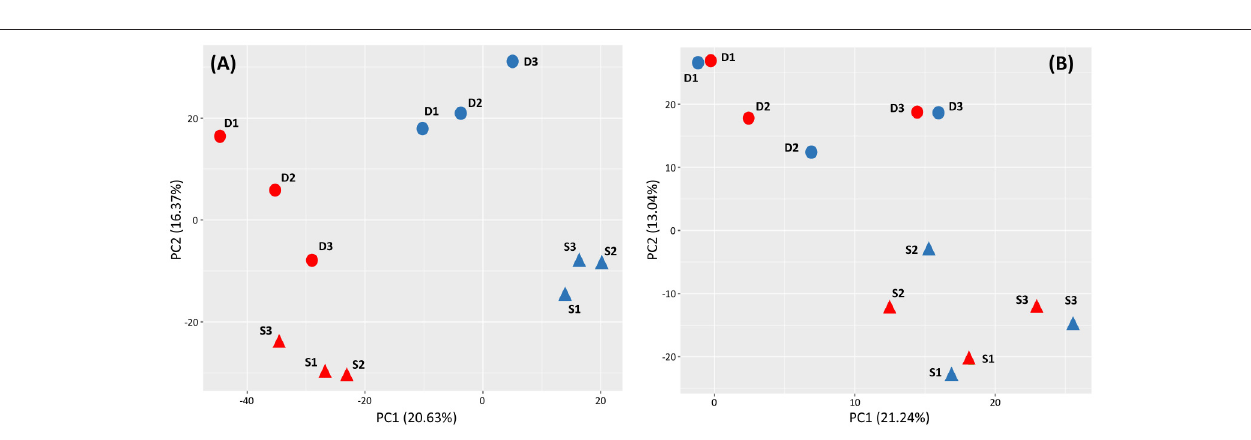
FIGURE 2 | Principal component analyses (PCA) performed with all 72,169 differentially expressed contigs (5% false discovery rate) found in shallow (triangles) and deep (circles) Posidonia oceanica plants at the end of the heat exposure (A) and recovery (B) periods. Heated and control plants are represented in red and blue, respectively. In parenthesis, the proportion of variance explained by principal components 1 and 2 is